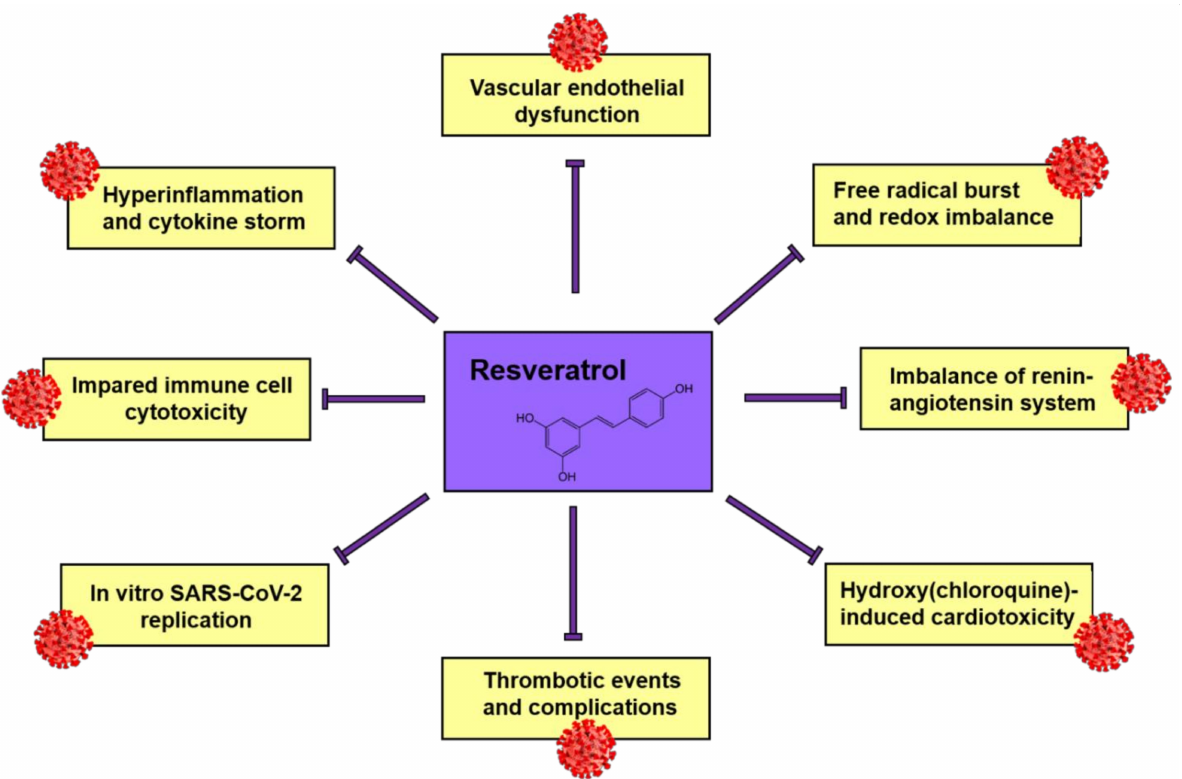
Figure 6. Potential of resveratrol in mitigation of COVID-19 infection severity related to